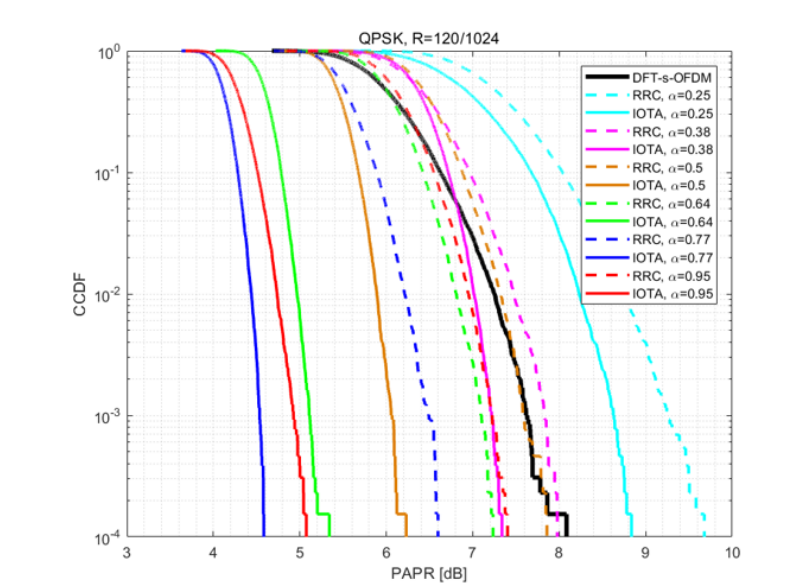
Figure 4. Performance of PAPR based on QPSK with R =